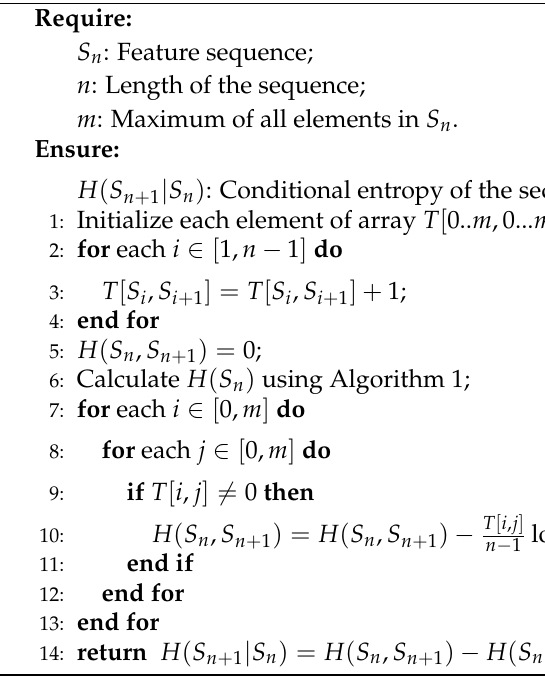
Algorithm 2: Calculating the Conditional Entropy of Feature